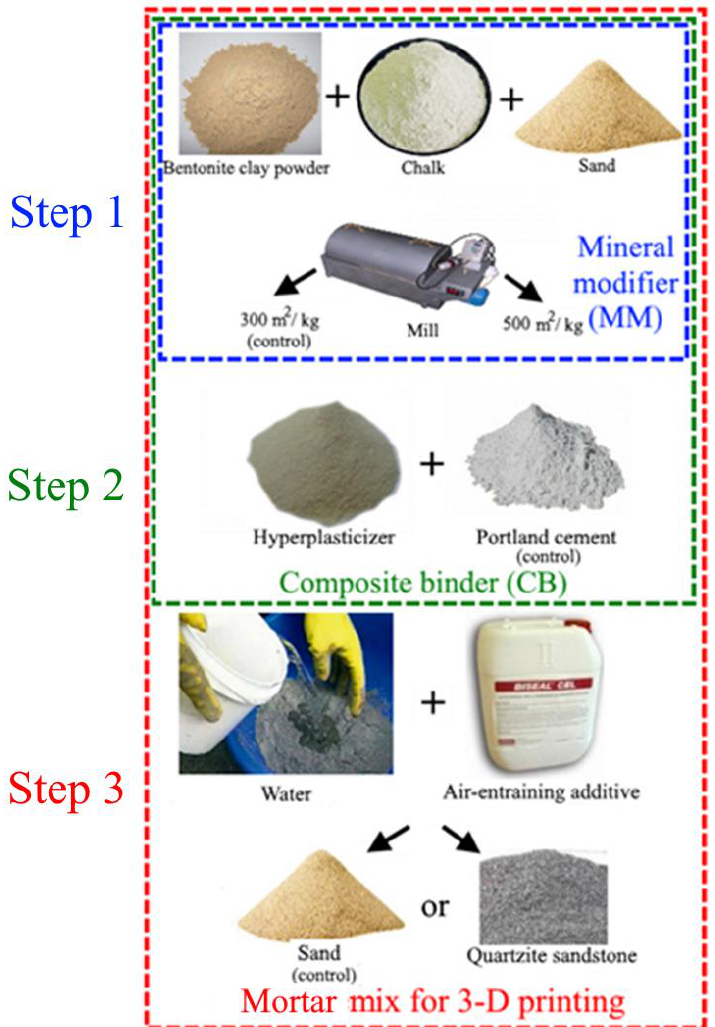
Figure 2. Flowchart of the mix preparation.